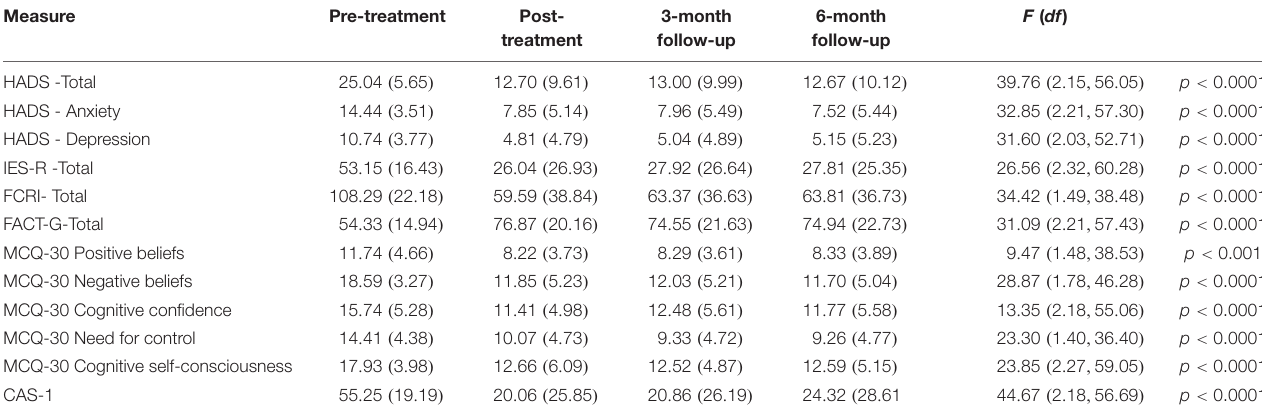
TABLE 2 | Means, standard deviations (in parentheses) and repeated measures analysis of variance for outcome measures: Intention-to-treat sample ( n = 27).